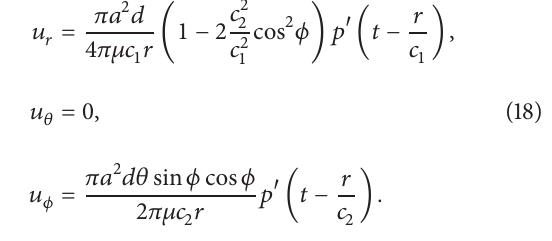
Figure 6: Diagrams of waves propagation from two couples of